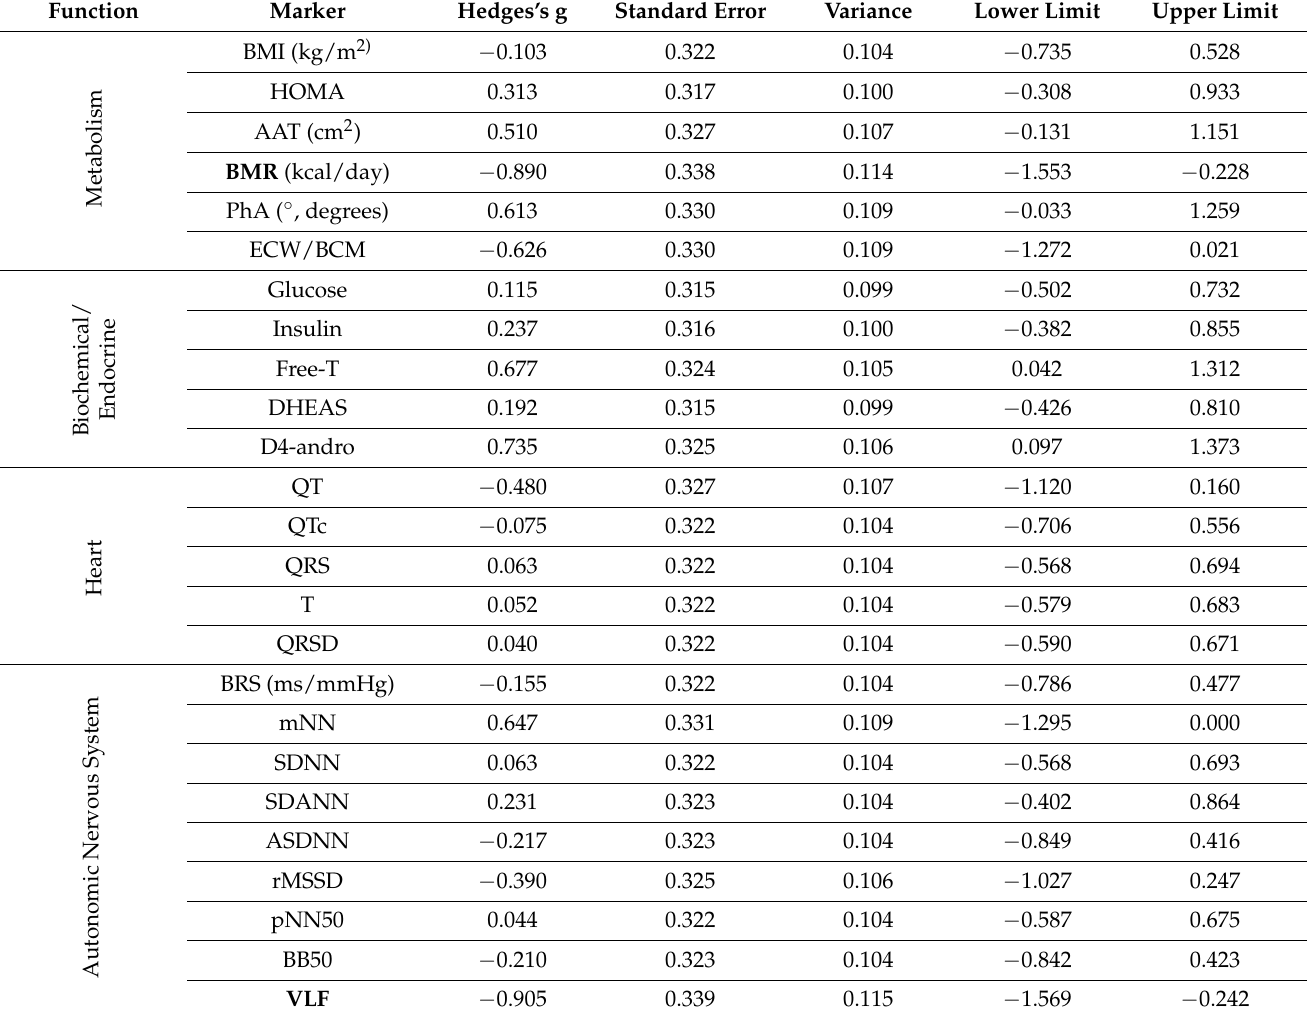
Table 1. Differences between case-control groups are presented in Hedge’s g (correction of Cohen d for small samples) and 95% Confidence Intervals, Standard Error, and Variance. Significant variables are marked in bold